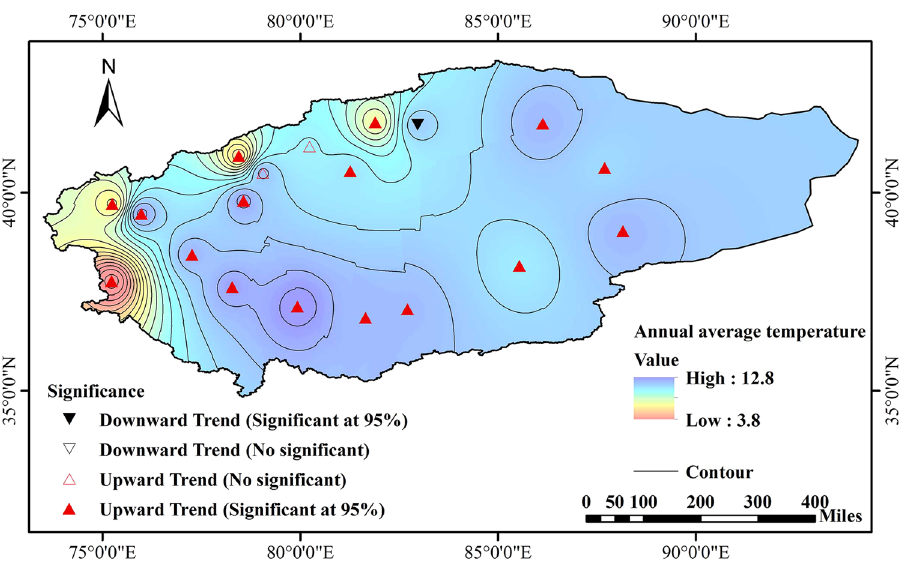
Figure 5. Spatial distribution of annual average temperature and trends of annual temperature measured by the Mann-Kendall test in the TRB (Note: the map was generated with data available from China Meteorological Data Sharing Service System (http://data.cma.cn) and the Chinese Geospatial Data Cloud using ESRI’s ArcGIS (version 10.1;